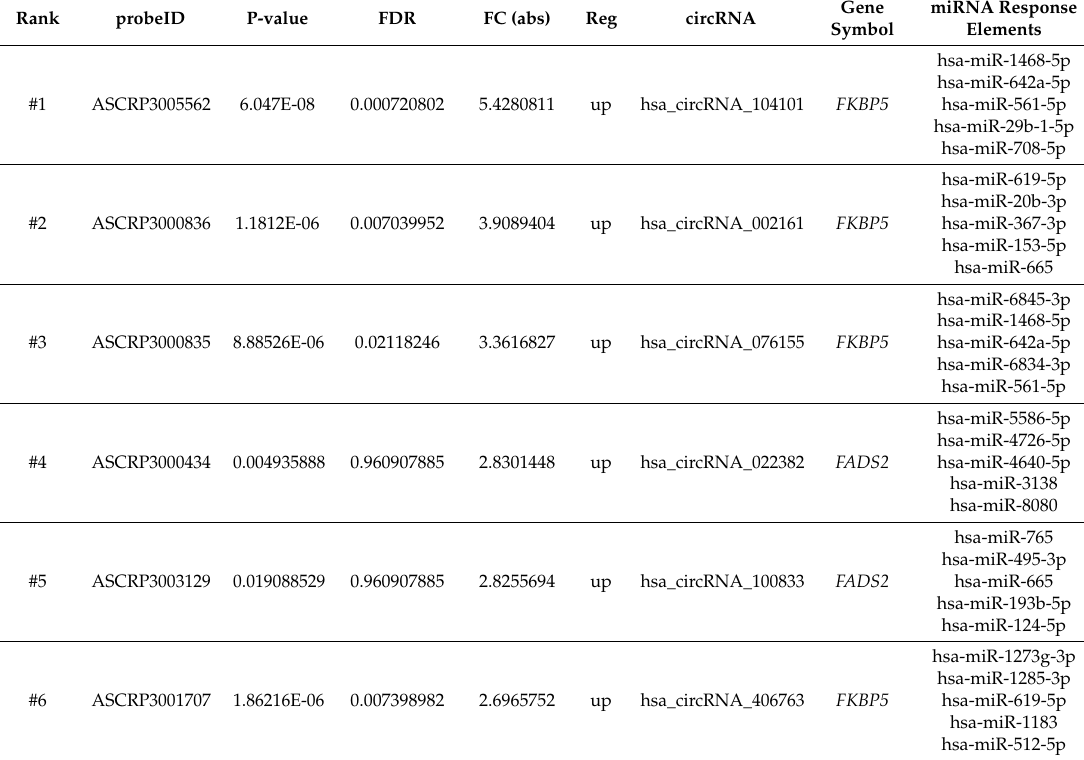
Table 1. Selection of di ff erentially-expressed circRNA in osteogenic di ff erentiation. CircRNAs are sorted and ranked by fold change. The results of hybridization arrays identified 21 upregulated and 21 downregulated circular RNAs in osteogenic di ff erentiation vs. undi ff erentiated